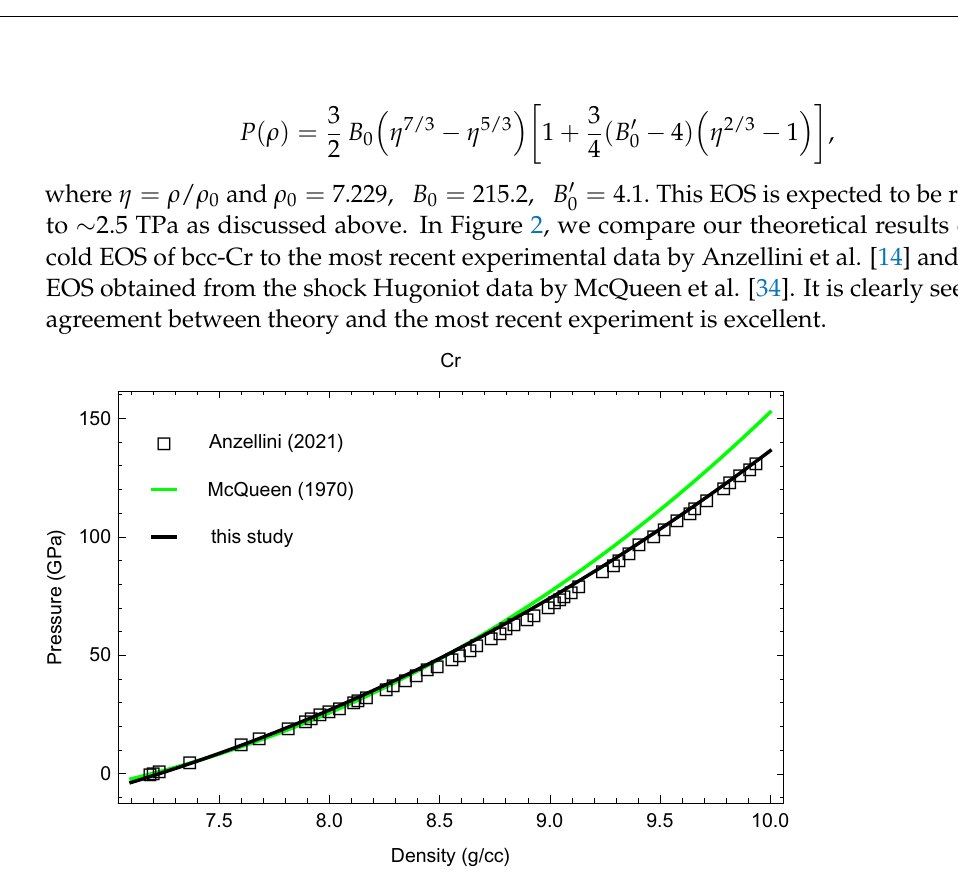
Figure 2. The cold equation of state of bcc-Cr: comparison of our theoretical results to the most recent experimental data (Anzellini, [14]) and the EOS obtained from the shock Hugoniot data (McQueen,